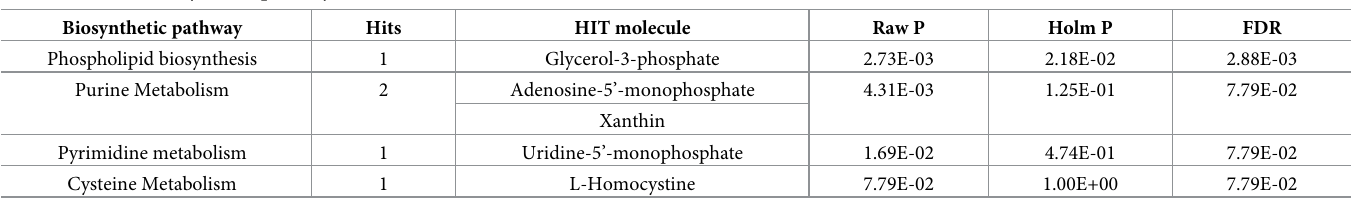
Table 3. Enriched biosynthetic pathways in the consortium.